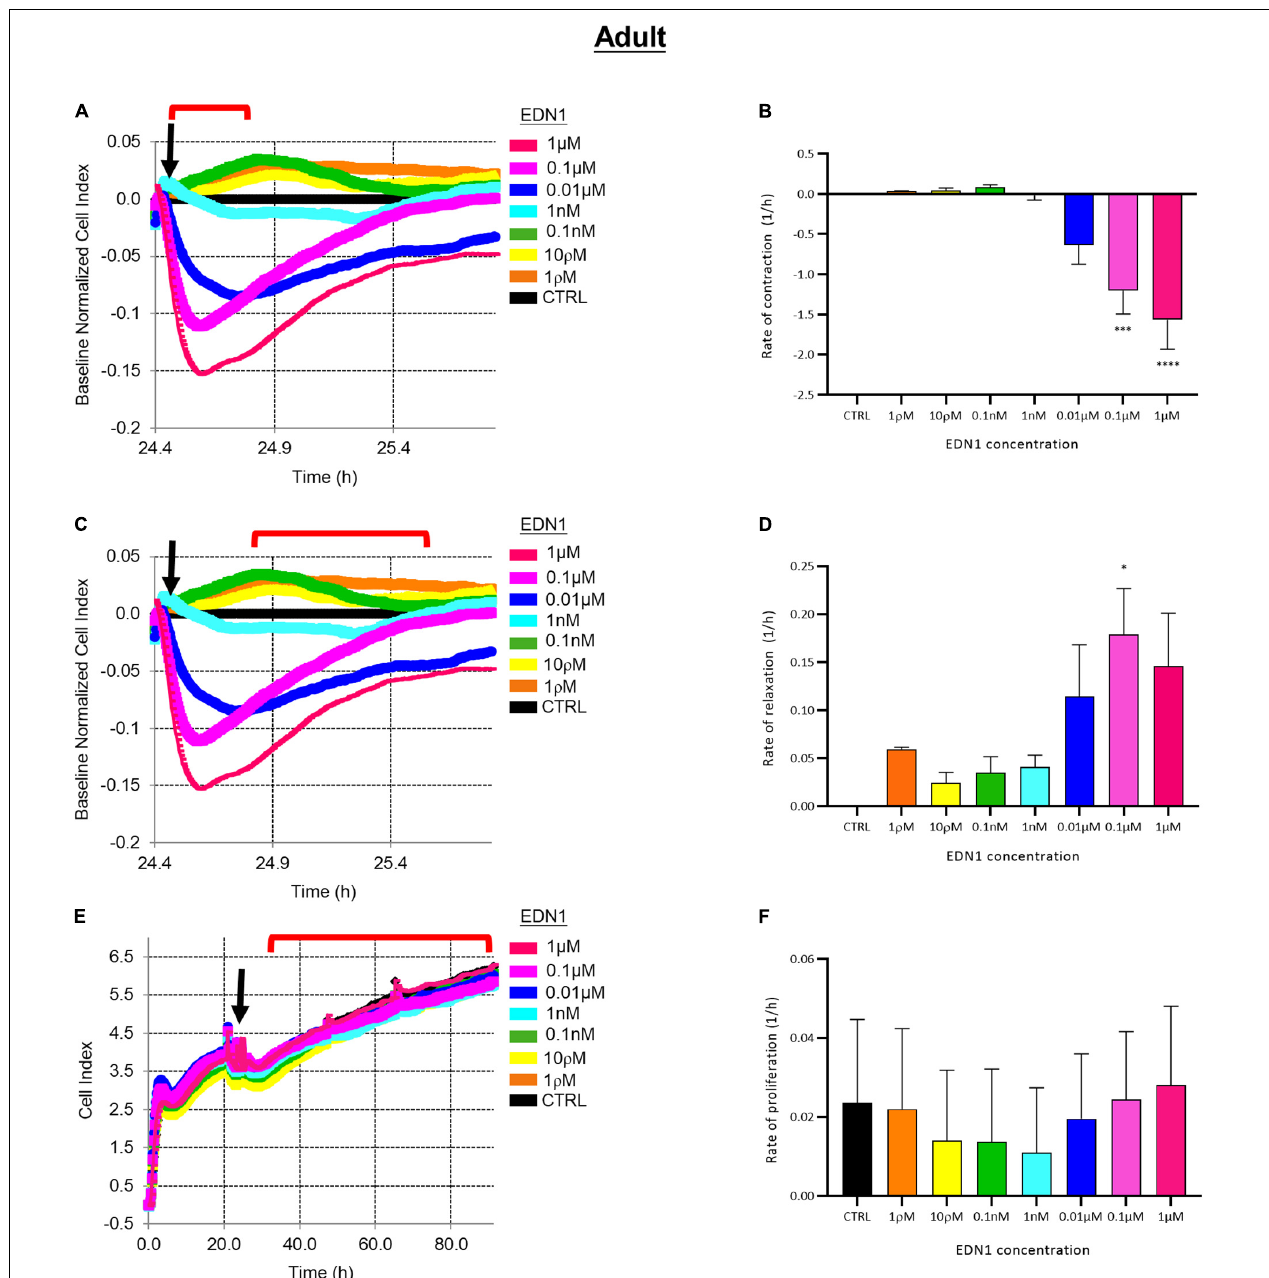
FIGURE 4 | (A) Representative electrical impedance measurements of the contractile response of adult human brain vascular pericytes (aHBVP) to EDN1. (B) The rate of contraction was significantly higher after adding 0.1 µ M ( p = 0.0008) or 1 µ M ( p < 0.0001) EDN1 ( n = 4). (C) Representative electrical impedance measurements of the relaxation response of aHBVP following contraction. (D) The rate of subsequent relaxation was significantly higher in cells to which 0.1 µ M ( p = 0.0159) EDN1 had been added ( n = 4). (E) Representative electrical impedance measurements of the proliferative response of the aHBVP to EDN1. (F) No significant difference in rate of proliferation between EDN1-treated and control cells was found ( n = 4). The timeframe referred to in each graph is indicated by the red bracket. Arrows indicate the timepoint of EDN1 addition. The bars represent the mean values and